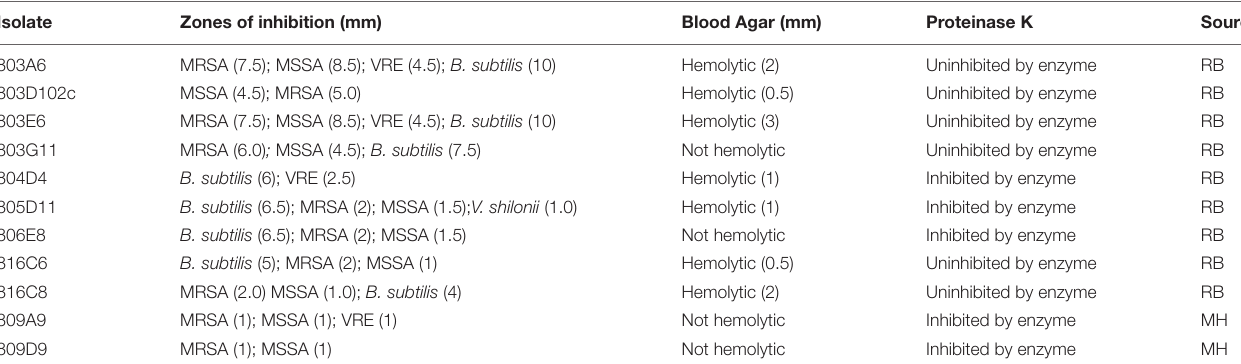
FIGURE 4 | A phylogenetic tree of antibiotic producing bacteria found in this study. Each taxon is colored based on host stingray species. The heatmap to the right represents the zone of inhibition (mm) of candidate strains against test strains. Clusters are designated as I, II, and II to the left of the heat map for discussion purposes. TABLE 3 | Blood agar and Proteinase K assays performed on a subset of broad-spectrum antibacterial-producing isolates. Isolate Zones of inhibition (mm) Blood Agar (mm) Proteinase K